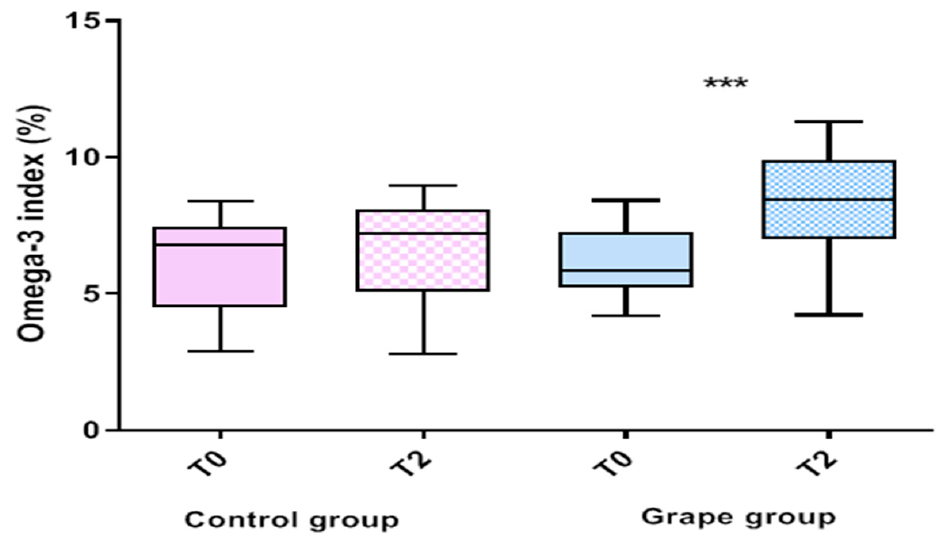
Figure 2. Omega-3 index levels in the serum from control and grape group at baseline (T0) and after 4 weeks from the end of grape treatment (T2). Data expressed as the mean percentage ± standard deviation. p -Value was determined by Paired t -test; *** p < 0.001.